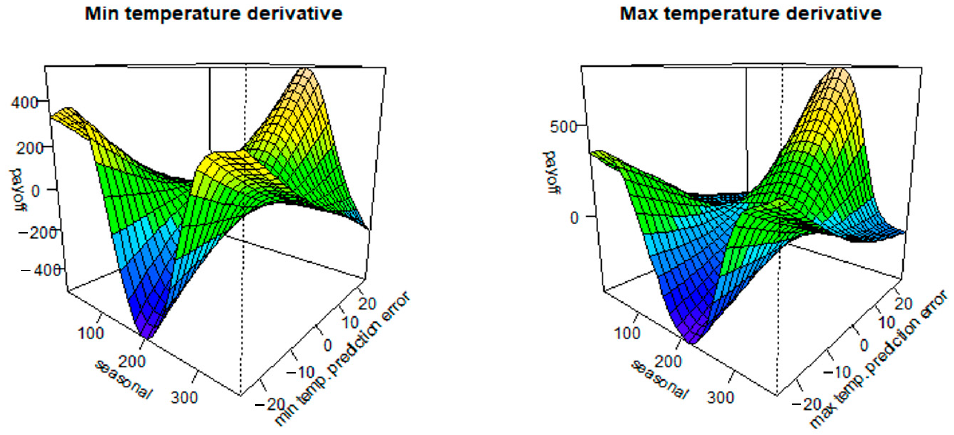
Figure 5. Estimated temperature derivatives’ payoffs in the demand model (12).